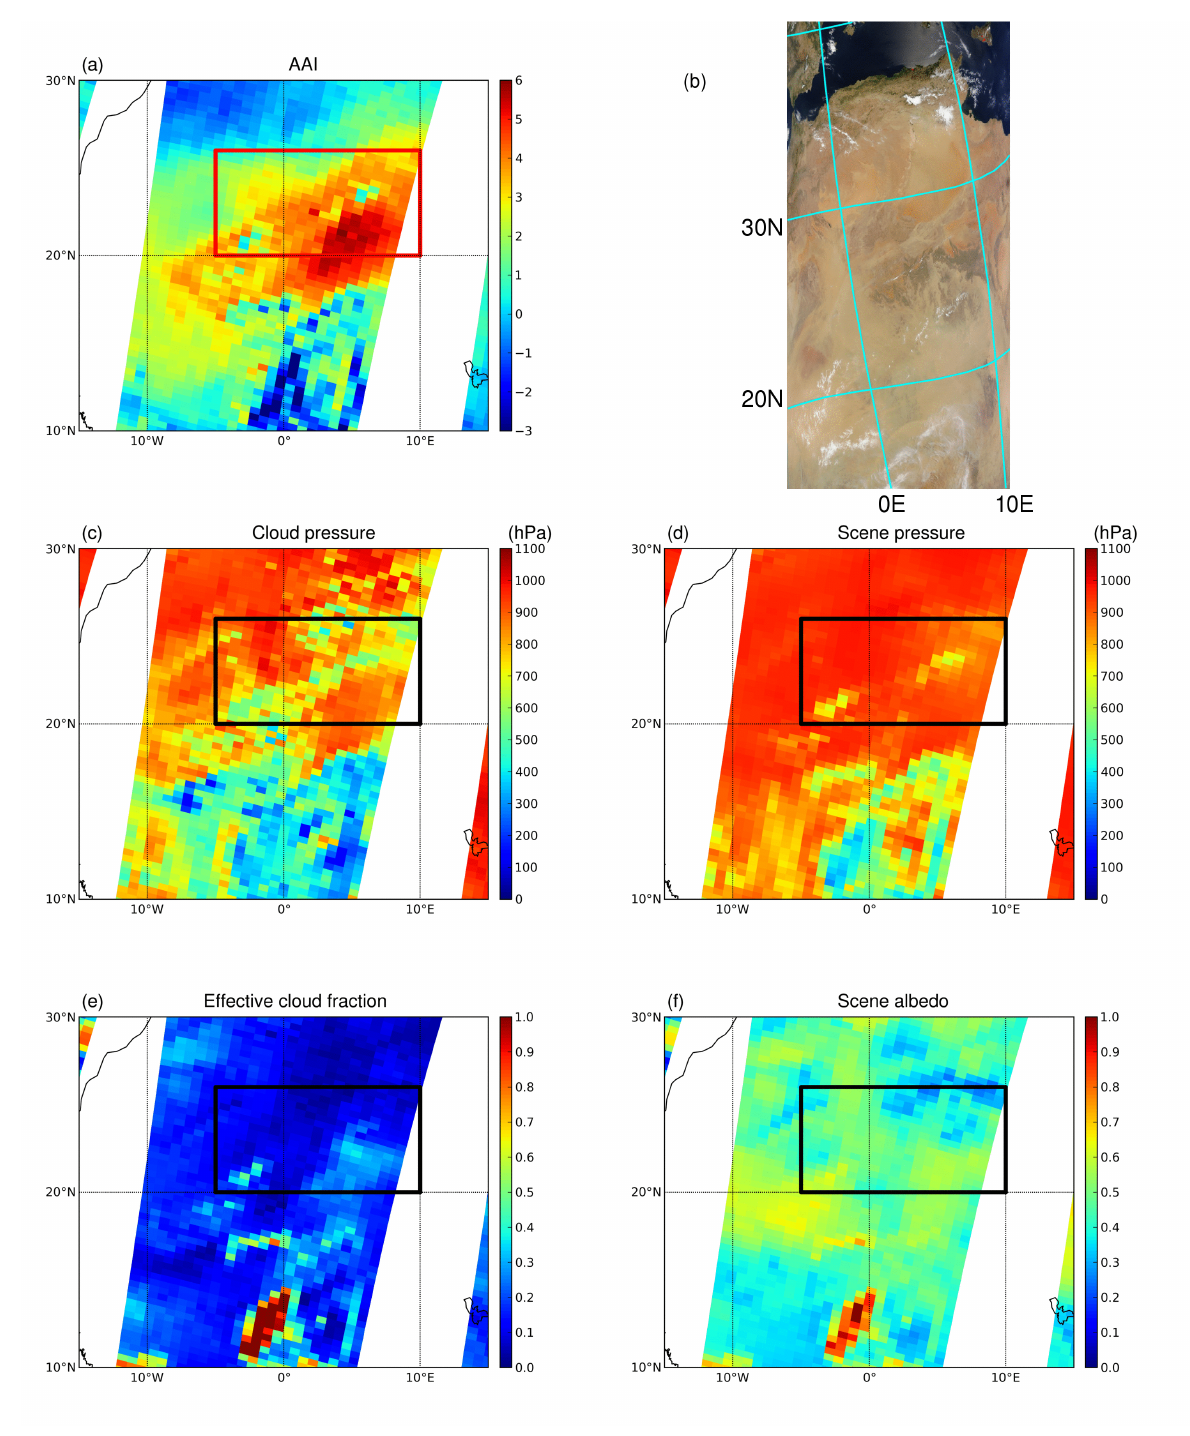
Fig. 14. (a) GOME-2 AAI image, (b) MODIS RGB image, (c) GOME-2 cloud pressure, (d) GOME-2 scene pressure, (e) GOME-2 effective cloud fraction, and (f) GOME-2 scene albedo for the Saharan desert dust event on 30 June 2010. The location of the plume is indicated with a box in the GOME-2 images. The plume in the box was measured around 09:45UTC. The MODIS image was measured at 10:30UTC. The MODIS image is downloaded from the MODIS Rapid Response System